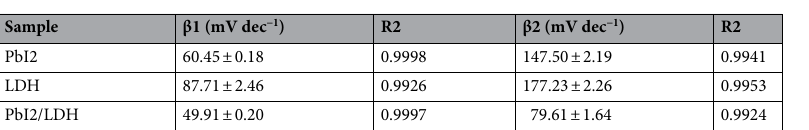
Table 1. β 1 and β 2 of the three photoelectrodes with the statistical parameters (standard deviations and correlation R 2 -coefficients).